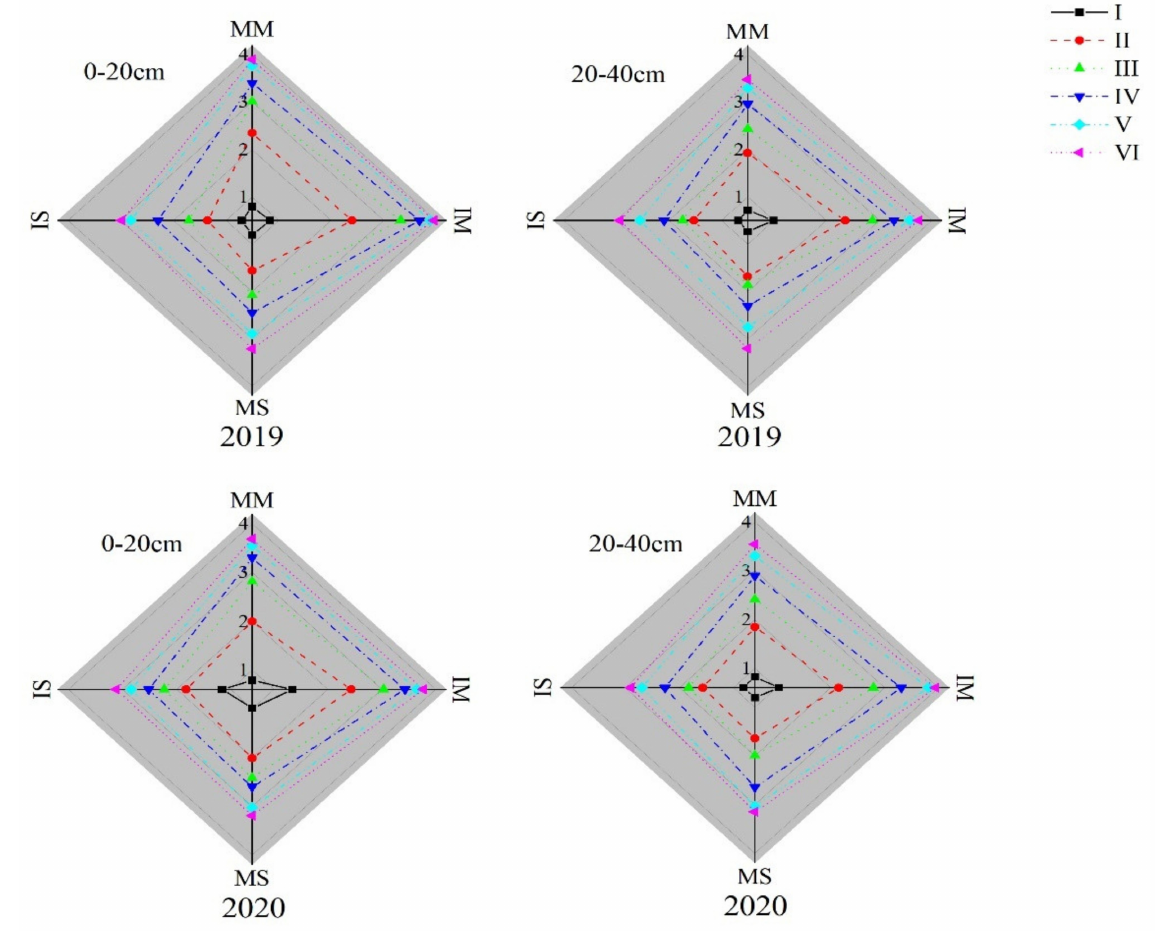
Figure 6. Dynamic changes of RLD of maize and soybean in monoculture and intercropping dur- ing 2019 and 2020. Abbreviations: MM—monocropping maize, MS—monocropping soybean, IM—intercropping maize, IS—intercropping soybean. In maize, I–VI mean seedling stage,